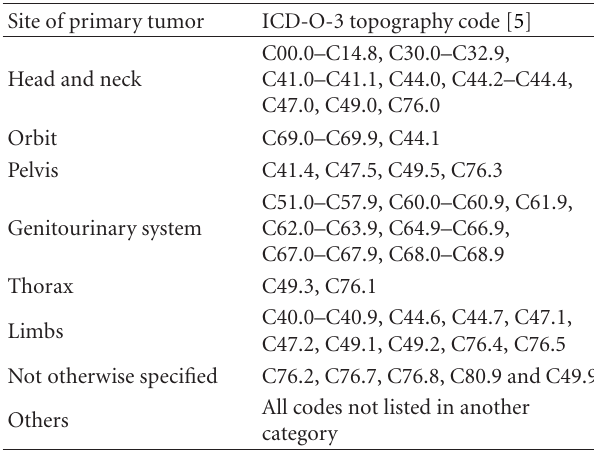
Table 1: Definition of the topographic categories of